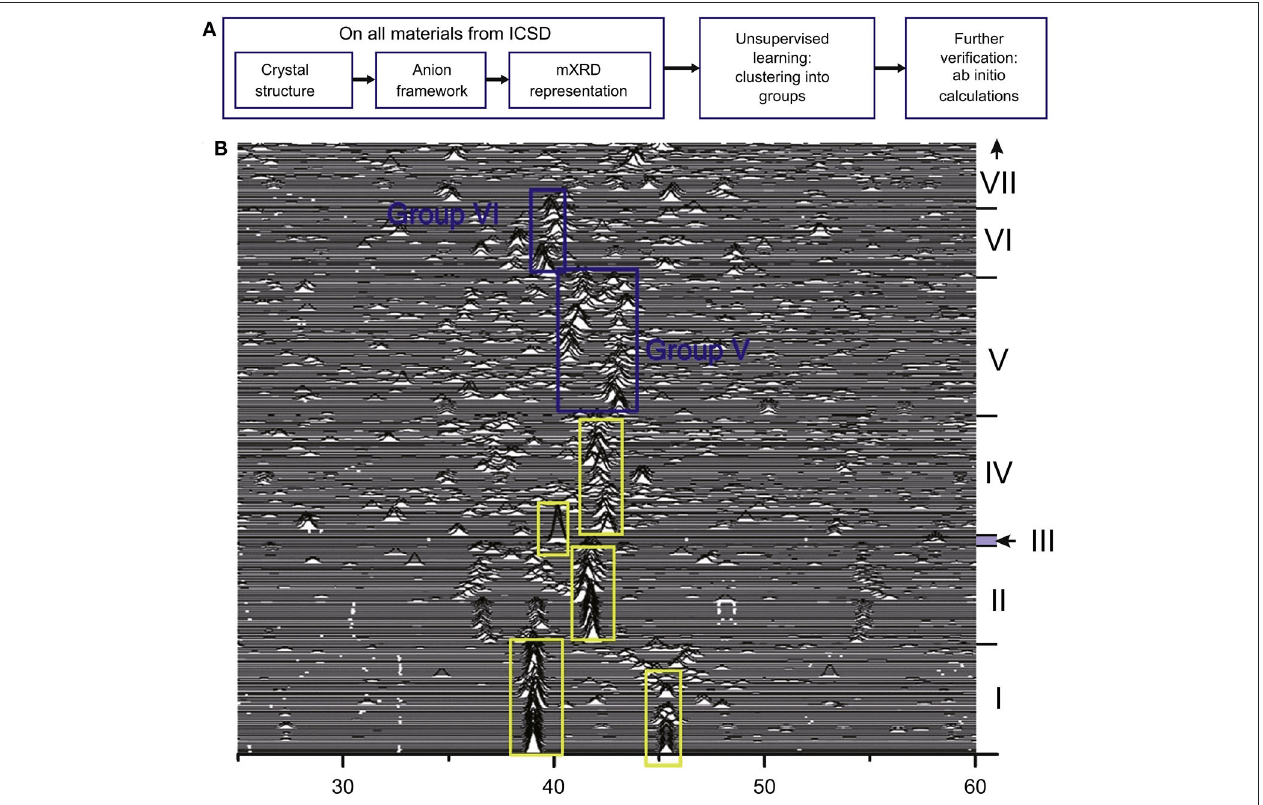
FIGURE 7 | (A) Workflow of the unsupervised ML for guiding discovery of SSLCs and (B) the modified XRD (mXRD). Reprinted with permission from Zhang et al. (2019b). Copyright (2019)